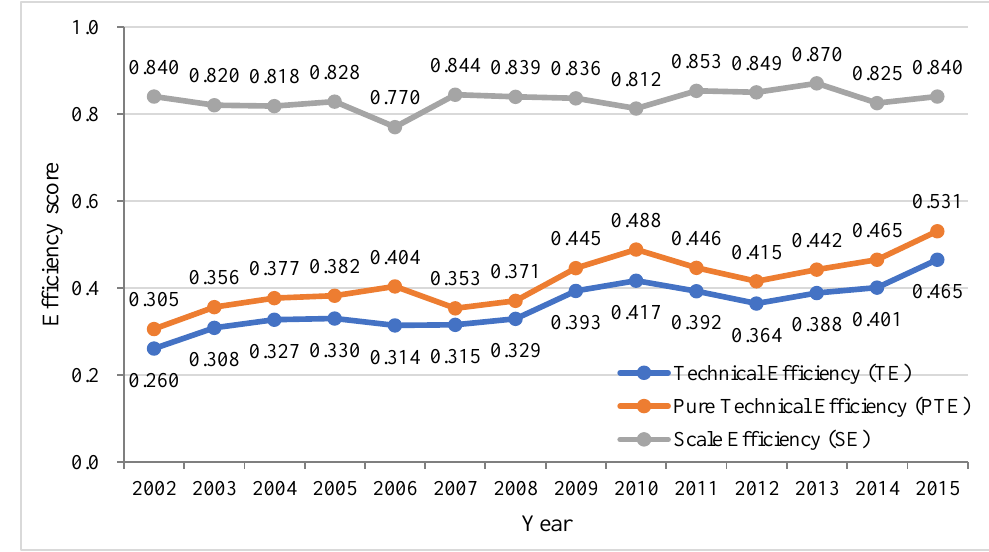
Figure 3. The annual change trends of TE, PTE, and SE of SLCP from 2002 to 2015. The PTE and SE obtained from the decomposition of the BCC model show that the interannual trend of PTE is basically the same as TE, increasing from 0.305 in 2002 to 0.531 in 2015, with an average annual growth rate of 5.27%, indicating that PTE is the most important factor affecting TE. In addition, SE fluctuated less between 2002 and 2015, with the average value remaining around 0.832 over the 14-year period, generally higher than TE and PTE, which again suggests that the lower TE is mainly due to the influence of the lower PTE. To further investigate the contribution of PTE and SE to TE more specifically, we used TE as the dependent variable and PTE and SE as the independent variables and plot- ted scatter plots separately using Stata 17.0 software to explore the correlation between them. As reflected in Figure 4, the scatter points representing SE are concentrated on the right side of the 45-degree diagonal line (Figure 4a), while the scatter points representing PTE are concentrated near the 45-degree diagonal line (Figure 4b), indicating that the number of counties with higher SE values in the Loess Plateau is more than the number of counties with higher PTE values, which further verified that PTE is the main contrib- uting factor for the low TE.